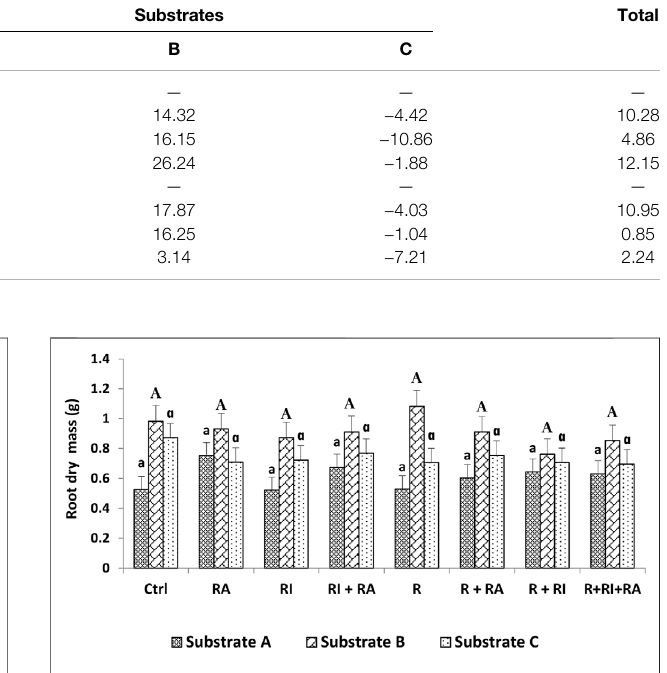
FIGURE 4 | Root dry mass of S. senegal seedlings that were grown on differentinoculated oruninoculated substratesinnursery conditions.